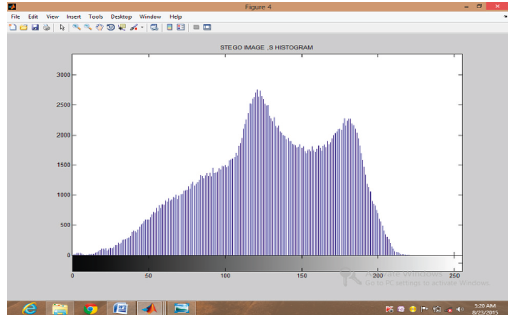
Figure 10: Histogram of stego image of trees.